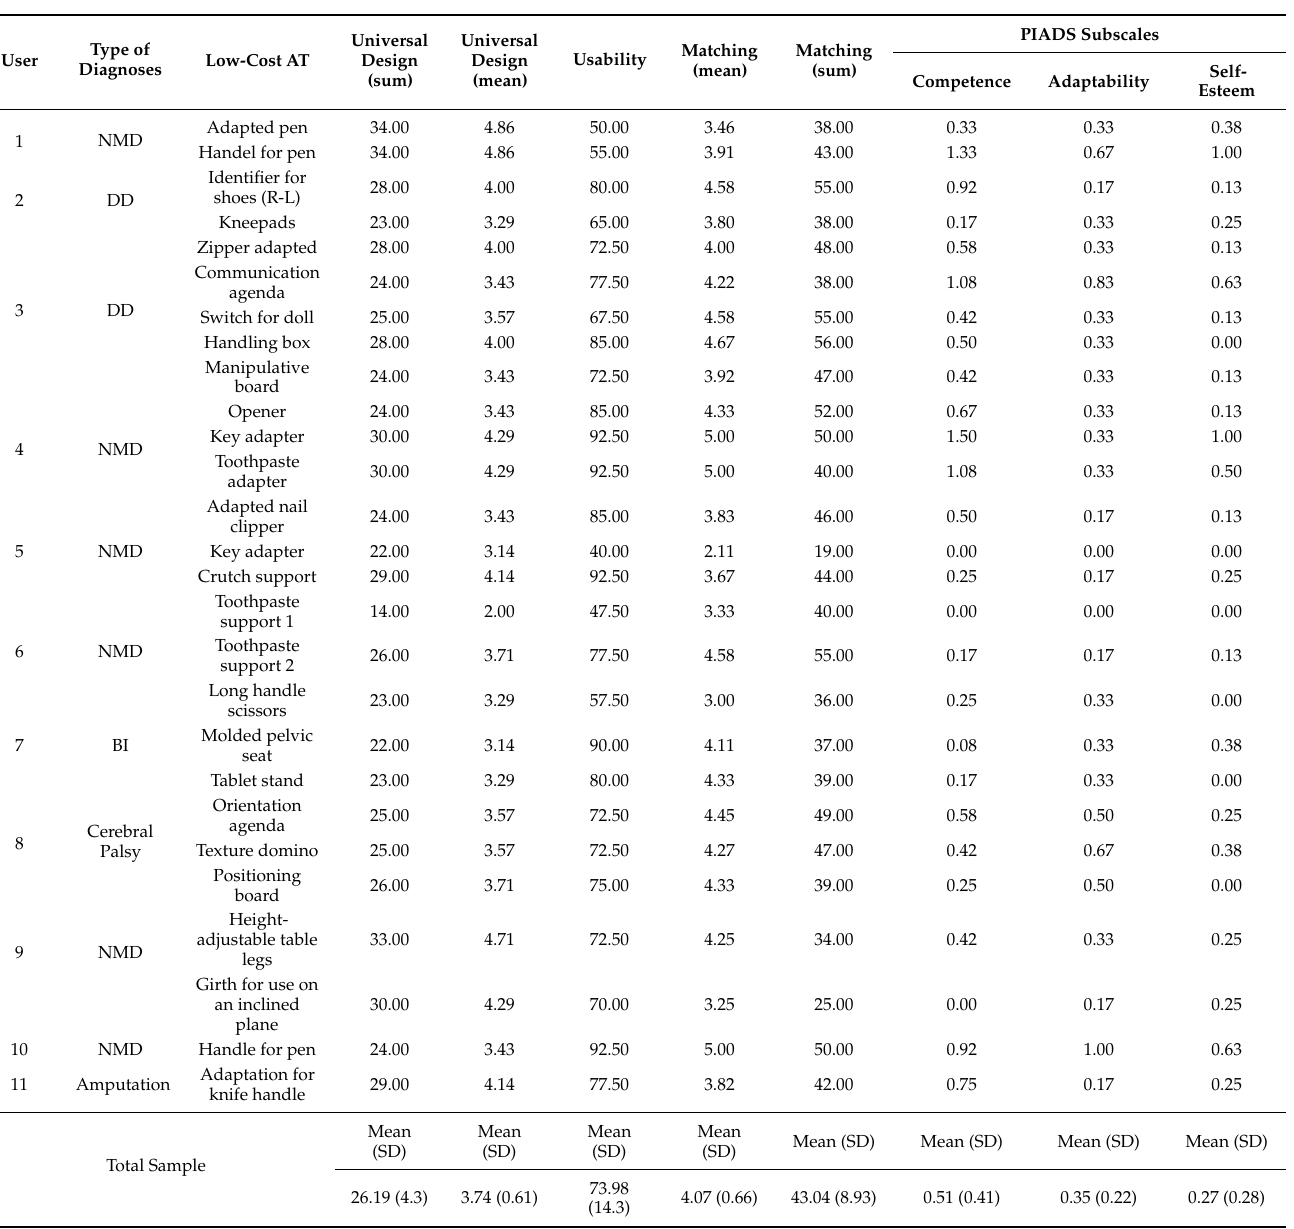
Table 3. Results from the application of the measure